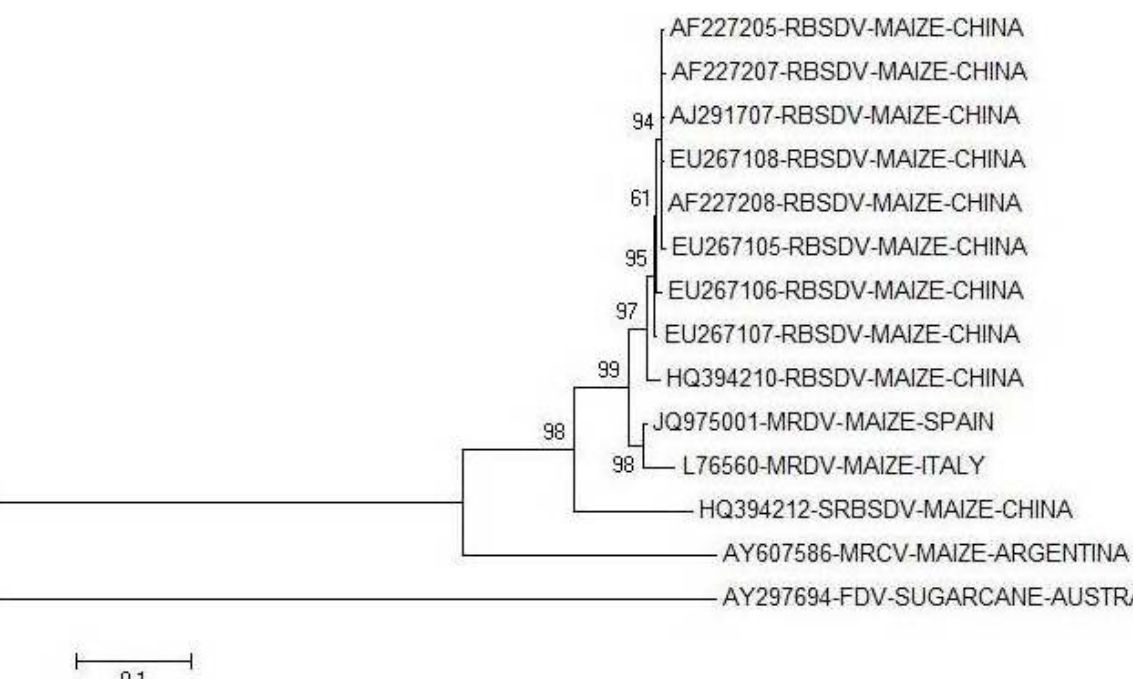
Figure 4. Phylogenetic tree constructed with amino acid sequences of ORF1 of segment 10 from Fijivirus that infect maize, using the neighbour joining method. The numbers above the branches indicate the frequency of the clusters after bootstrap analysis (1000 replicates). Branches with bootstrap values <50% were collapsed, and only branches with bootstrap values ≥80% are shown.